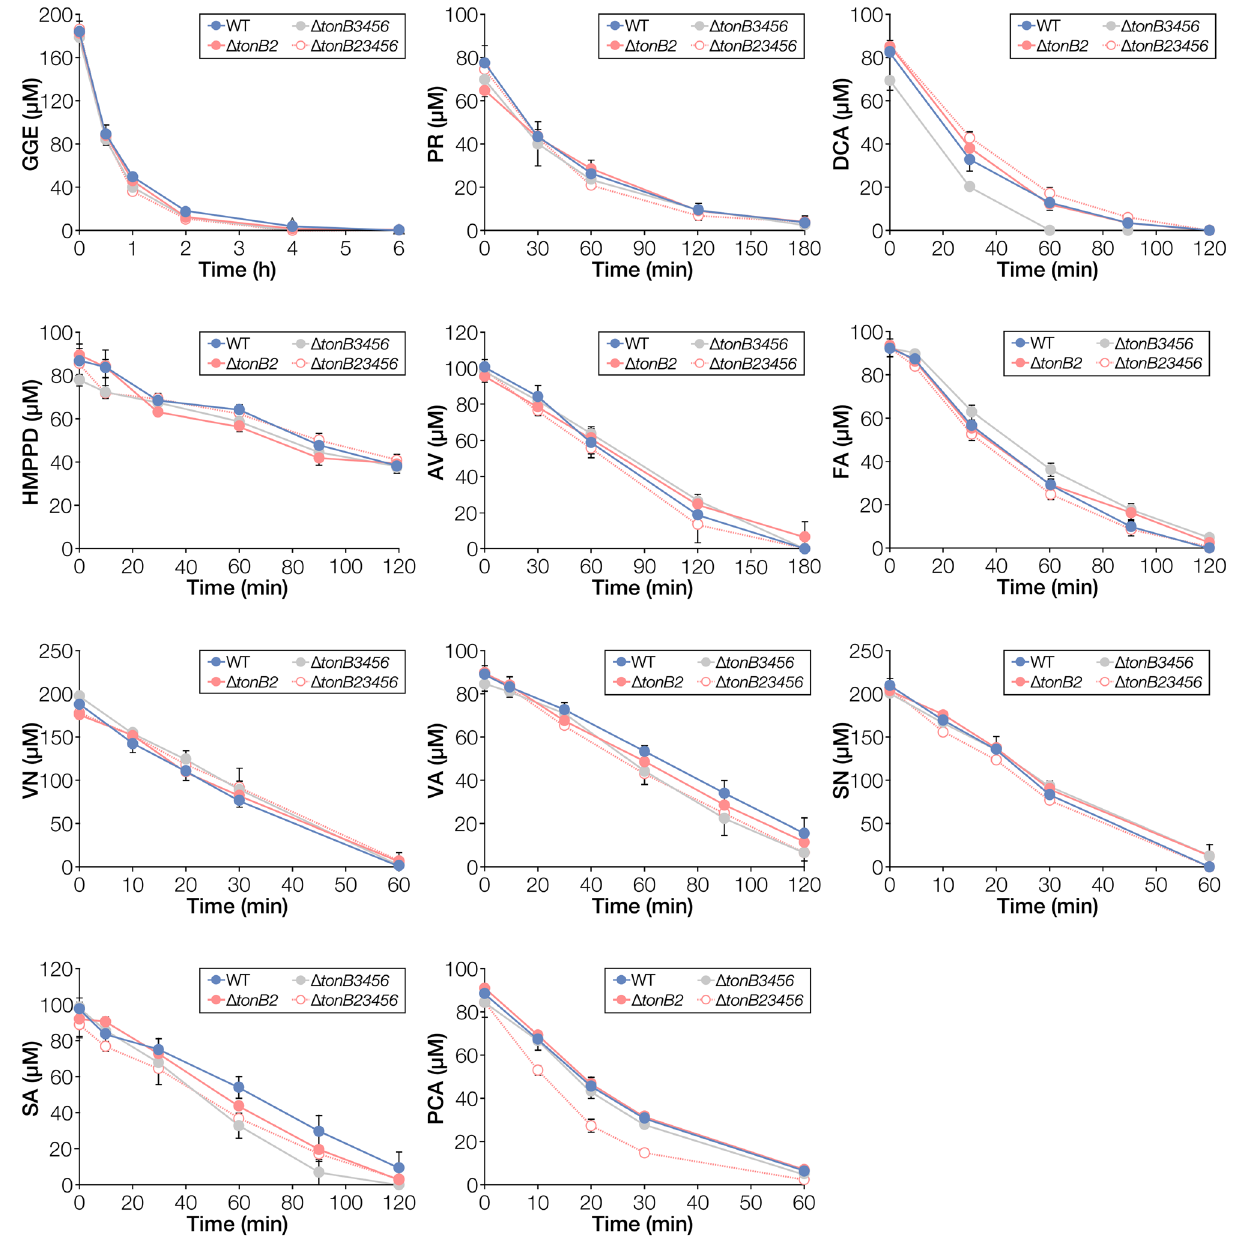
Figure 2. Conversion of lignin-derived aromatic compounds by resting cells of tonB multiple mutants. Cells of SYK-6, ∆ tonB2 , ∆ tonB3456 , and ∆ tonB23456 were incubated with 200 µM GGE, 100 µM PR, 100 µM DCA, 100 µM HMPPD, 100 µM AV, 100 µM FA, 200 µM VN, 100 µM VA, 200 µM SN, 100 µM SA, or 100 µM PCA. Portions of the reaction mixtures were collected, and the amount of substrate was measured using HPLC. Each value is the average ± the standard deviation of three independent experiments. This figure was generated using Canvas X Draw version 7.0.2. (https:// www. canva sgfx. com/ produ cts/ canvas- x-